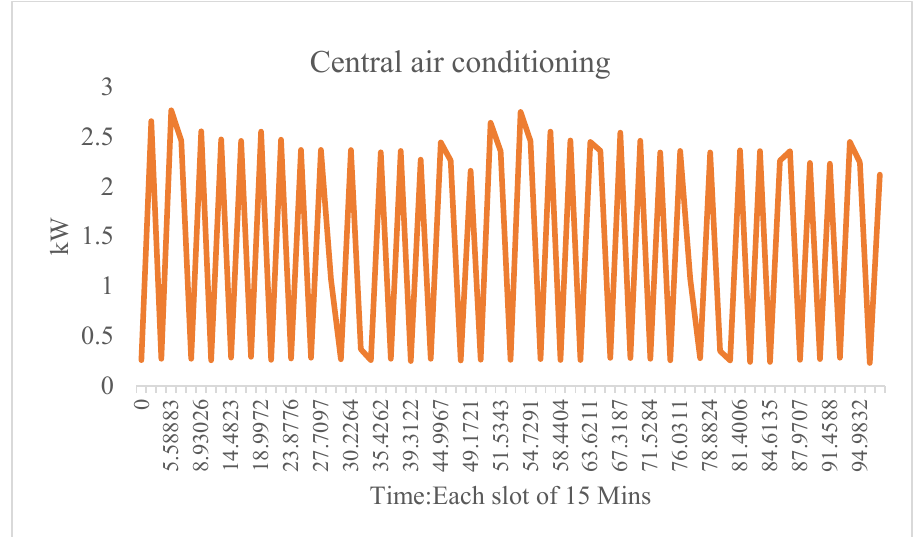
Figure 7. Central air conditioning.